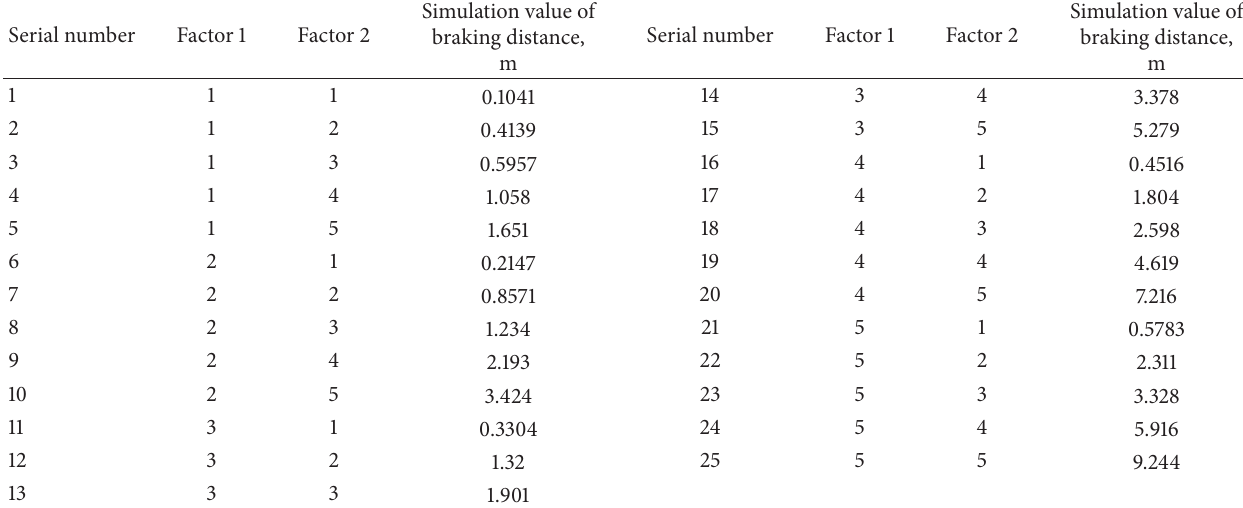
Table 3: Simulation results of tramcar braking distance.